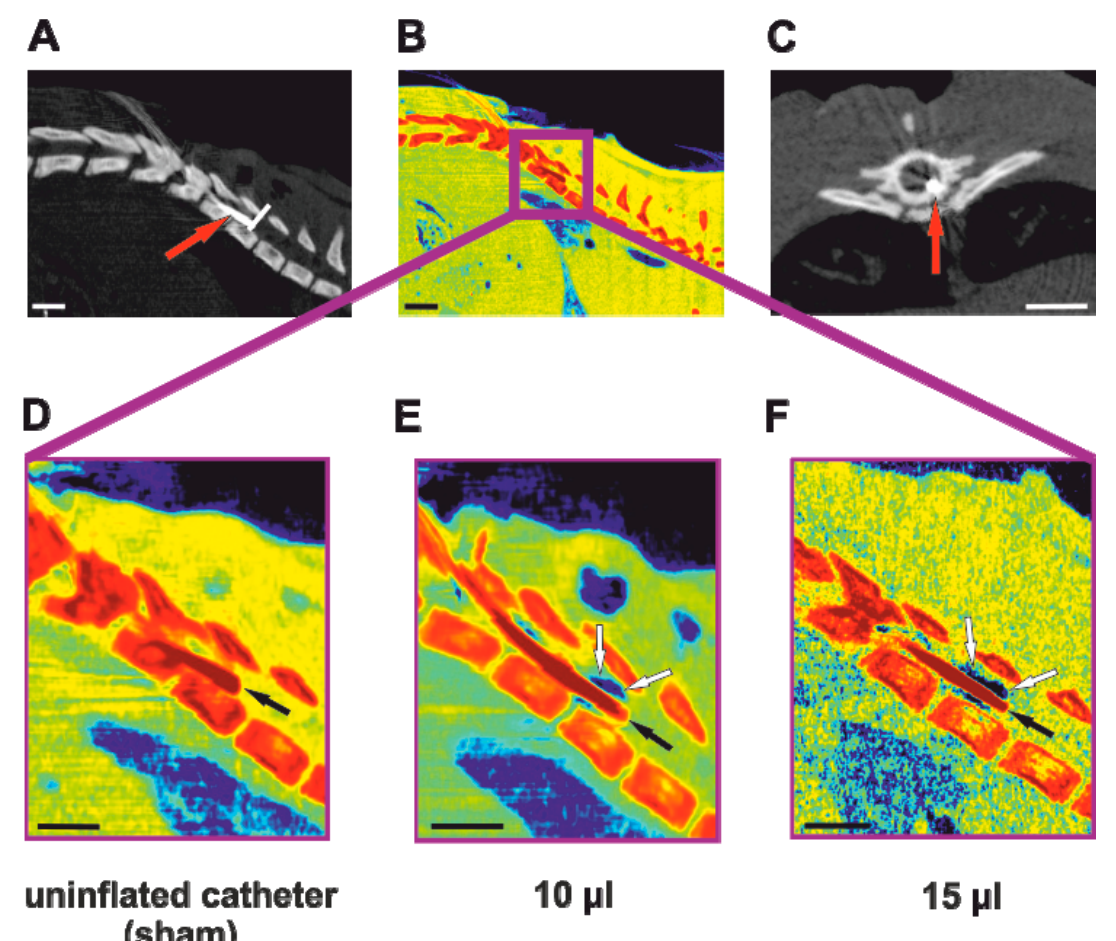
Figure 2. Micro computed tomography (CT) images of ventral epidural catheter placement. In order to evaluate the position of the catheter (red arrows) in front of the spinal cord, micro CT with bone window ( A , C ) and soft tissue window ( B ) were applied. Furthermore, detailed images of the deflated balloon ( D ), as well as inflated to 10 μ L ( E ) and 15 μ L ( F ) volume balloon were obtained. Black arrows show the wire of the catheter, whereas white arrows point to the imaged saline solution indicating the amount of inflated Fogarty´s balloon. Scale bar: 2 mm.